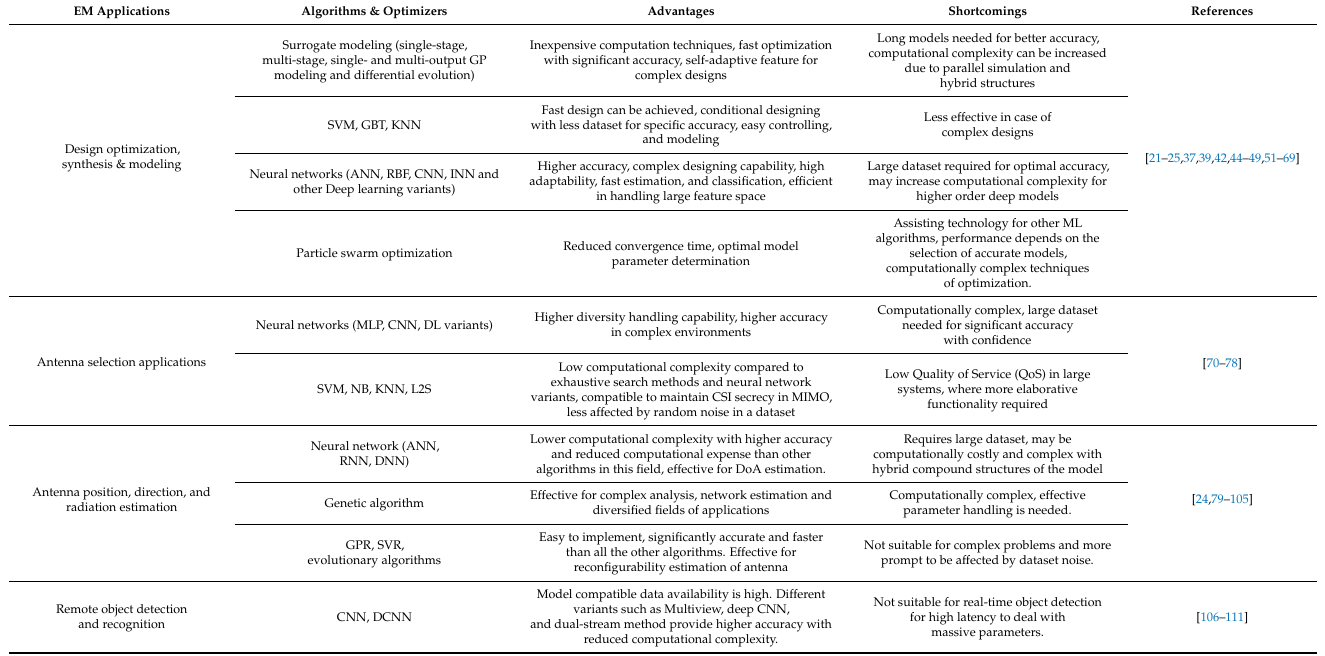
Table 1. Qualitative comparison of different ML algorithms based on EM